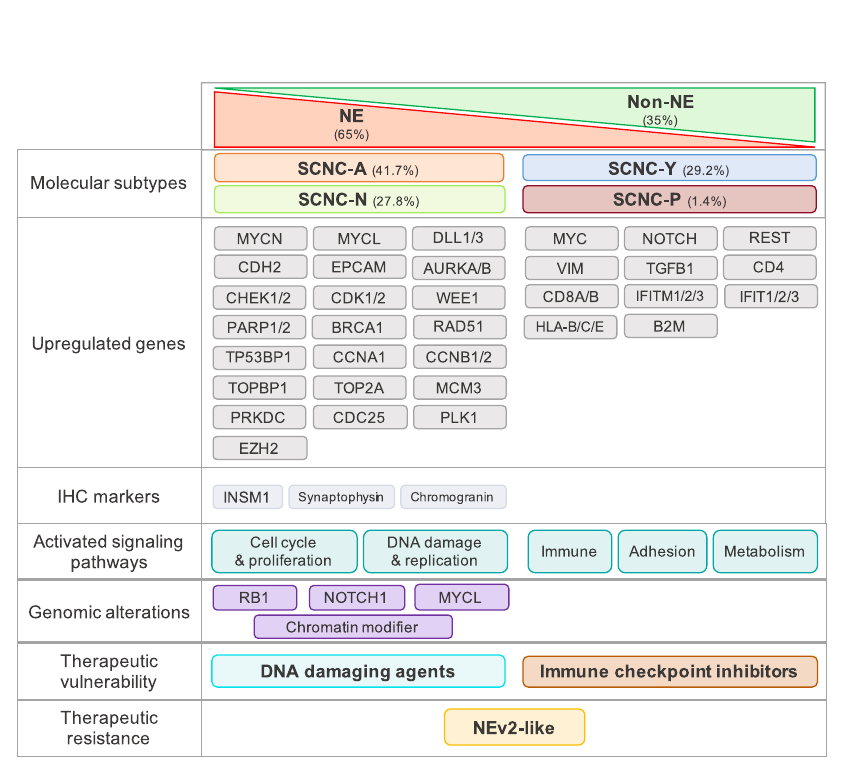
Fig. 6 Association between SCNC subtypes and response to therapy. a Kaplan – Meier curves of OS from the date of diagnosis in patients with tumors of NE and non-NE phenotypes. b Proportion of patients deriving clinical bene fi t from ATR inhibition and immunotherapy categorized by NE subtypes. Two- tailed chi-square, ** P = 0.0024, * P = 0.0464. c Kaplan – Meier curves of PFS in patients treated with ATR inhibitor and immunotherapy categorized by